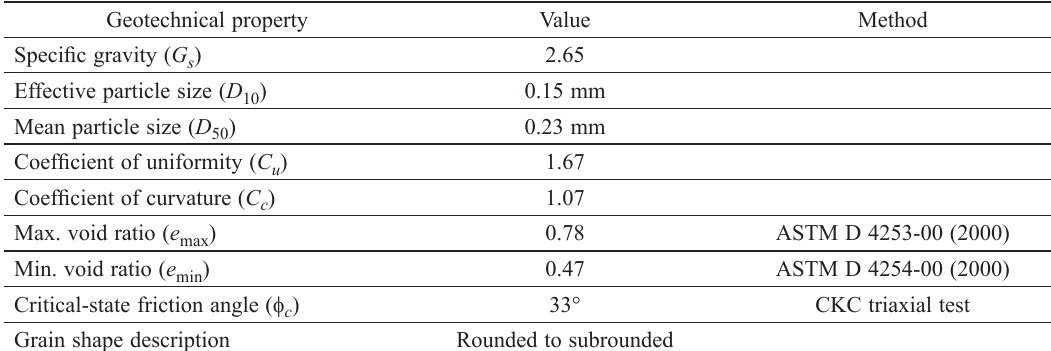
Table 1. Engineering properties of F-55 sand